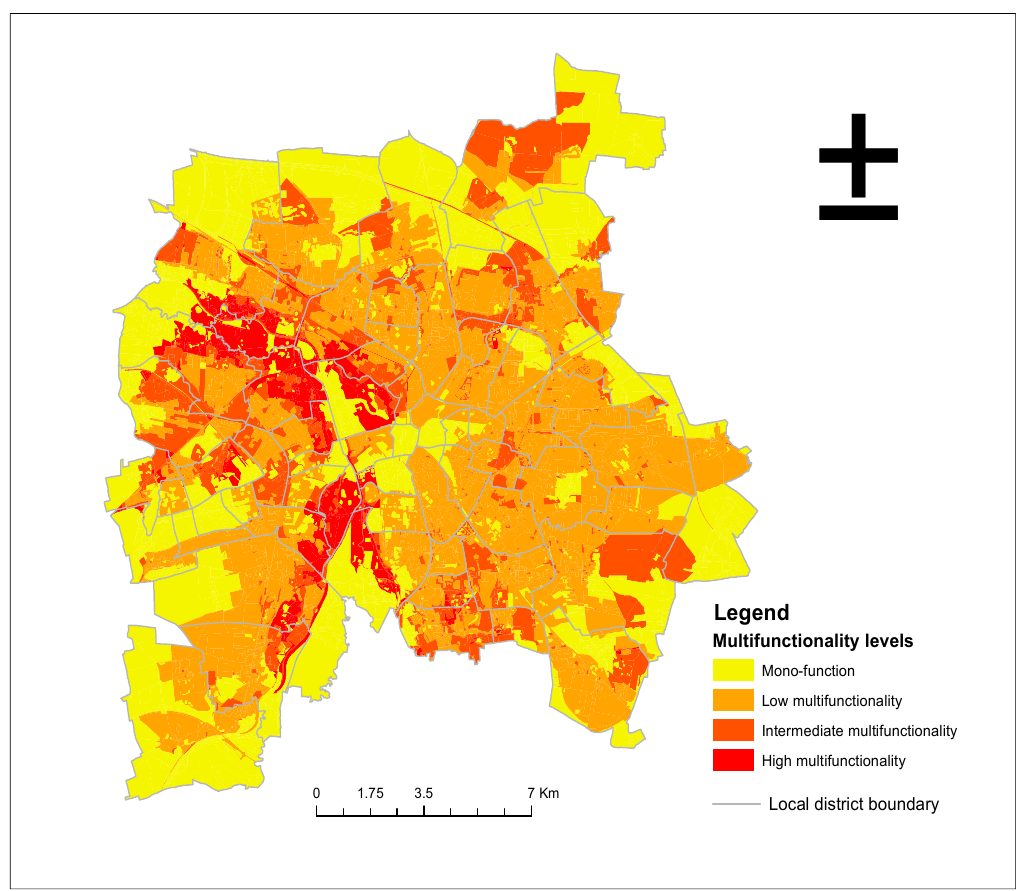
Figure 8. Spatial distribution of GI multifunctionality in Leipzig, Germany.